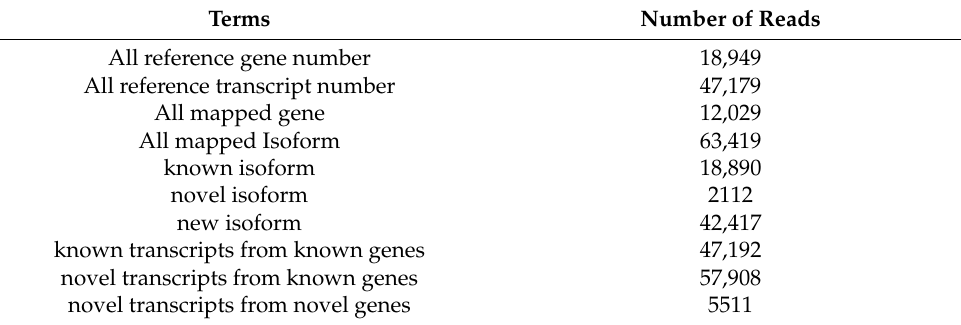
Table 2. Statistical table results of gene